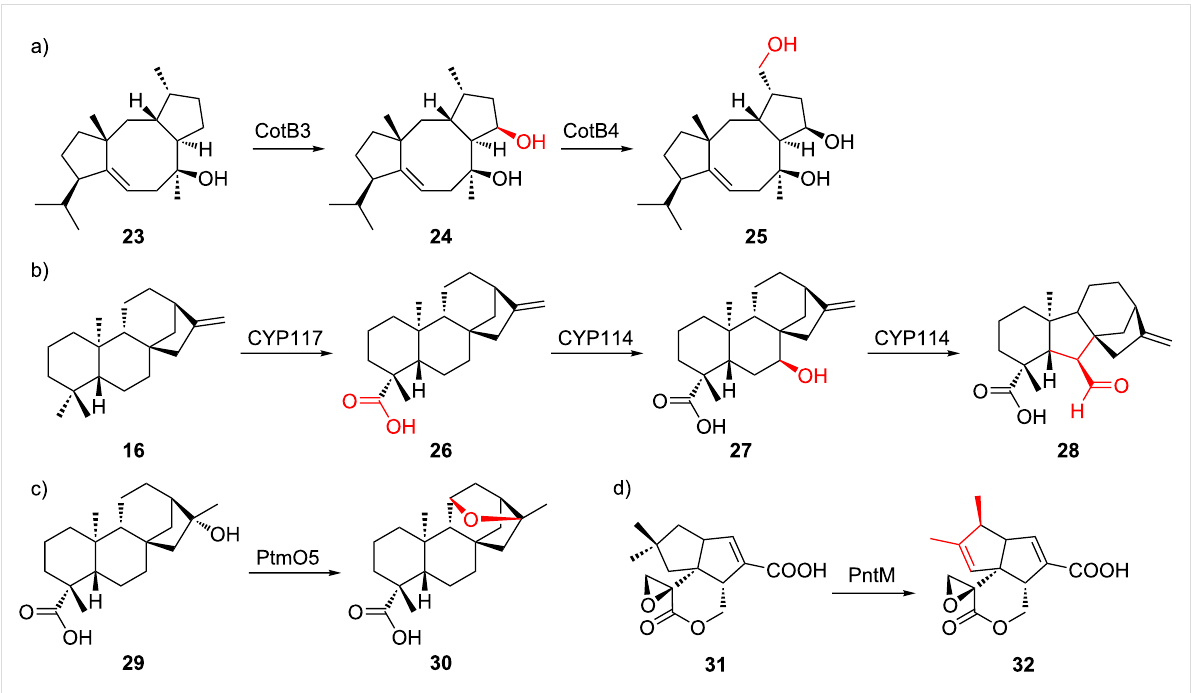
Figure 7: Selected examples of terpene modification by bacterial CYPs. a) Hydroxylation [89]. b) Carboxylation, hydroxylation, and ring contraction [41]. c) Ether formation [90]. d) Rearrangement